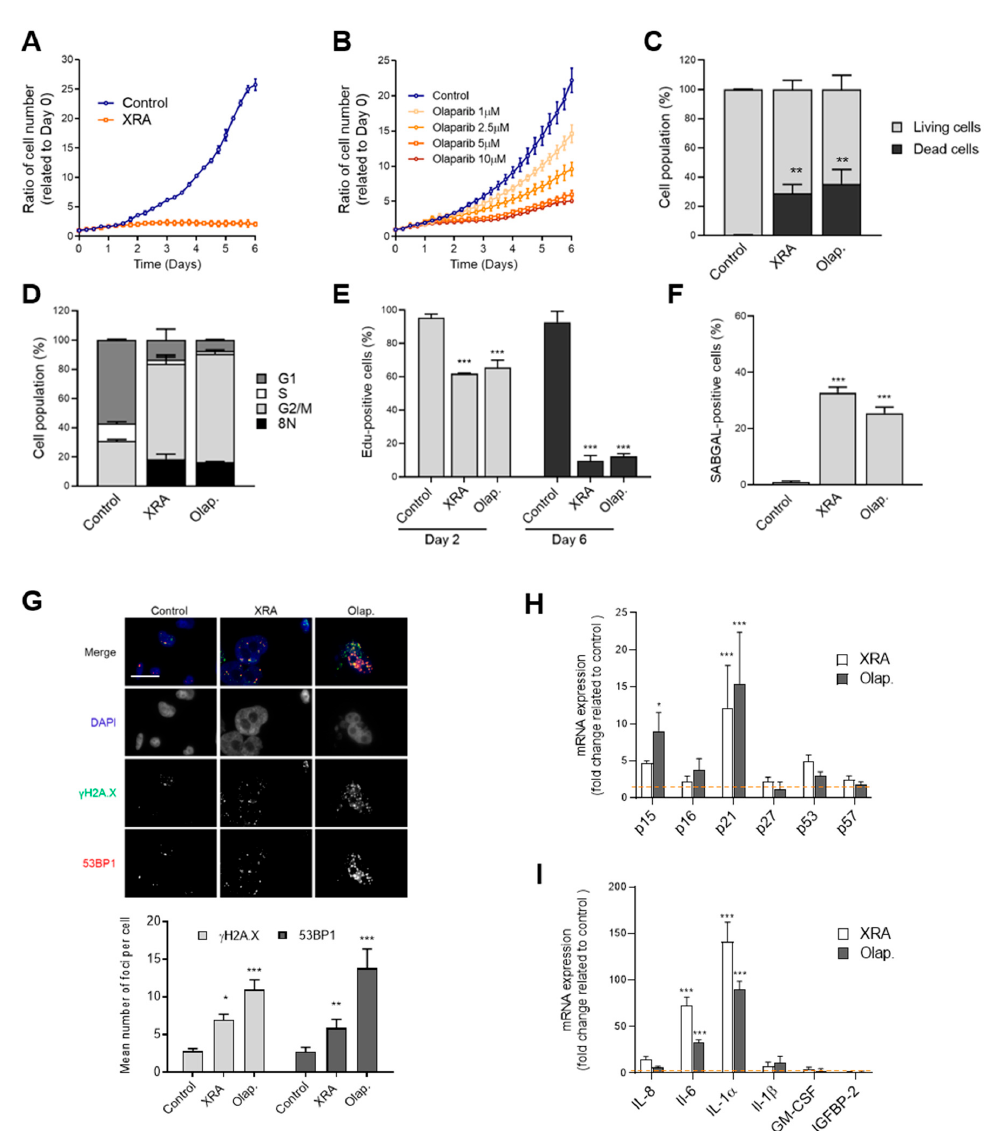
Figure 2. Therapy-induced DNA damage triggers mixed cell fates in PC-3 cells ( A , B ) Cell proliferation curves of PC-3 expressing H2B-GFP and ( A ) irradiated with 8 Gy of X-rays (XRA) or ( B ) treated with increasing concentrations of olaparib (Olap). ( C – I ) PC-3 cells were irradiated with 8 Gy XRA or treated with 5 µ M Olap. Data are the mean ± SD of triplicate and are representatives of three independent experiments. ( C ) The cumulative cell death of PC-3 was analyzed by flow cytometry 6 days after XRA or Olap treatment. ( D ) Flow cytometry analysis of cell cycle populations following 6 days of exposure of PC-3 cells to XRA or Olap. ( E ) Cell proliferation was assessed by incorporation of EdU for 24 h at 1 or 5 days after XRA or Olap treatment. ( F ) SA- β -gal assay was performed on PC-3 cells 6 days after XRA or Olap treatment. ( G ) Representative images (top) and quantifications (bottom) of γ H2AX (green) and 53BP1 (red) foci per nucleus in PC-3 cells 6 days following XRA or Olap treatment. The merged red and green channels show colocalization in yellow and DAPI is shown in blue. Scale bar = 20 µ M ( H , I ) Relative mRNA levels of ( H ) CDKi or ( I ) SASP factors were evaluated by real-time Q-PCR in PC-3 cells irradiated or treated with Olap for 6 days. The values represent the fold change expression related to non-treated controls (represented by the dashed line). ( C – I ) The mean ± SD of three independent experiments is shown. Statistical analysis: ( C , E , F , G ) two-tailed Student’s t -test; ( H , I ) two-way ANOVA. * p < 0.05, ** p < 0.01, *** p <